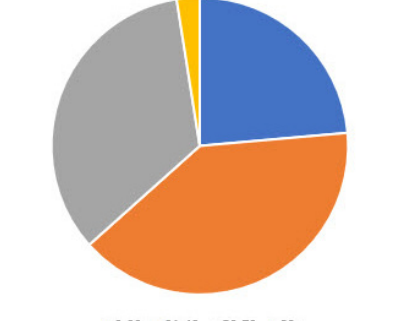
Figure 1. Survey results by the total number of points on the IAT test